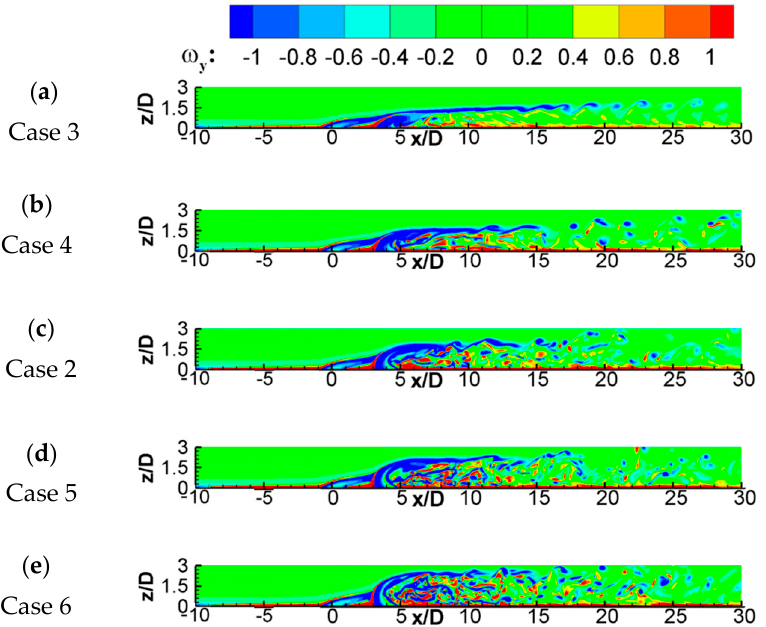
Figure 11. The contours of instantaneous spanwise vorticity ω y on the mid-span plane of double rows film cooling with various backward-downstream-jet blowing ratios of ( a ) 𝐵𝑅 = 0.20 , ( b ) 𝐵𝑅 = 0.35 , ( c ) 𝐵𝑅 = 0.50 , ( d ) 𝐵𝑅 = 0.65 , and ( e ) 𝐵𝑅 = 0.80 .